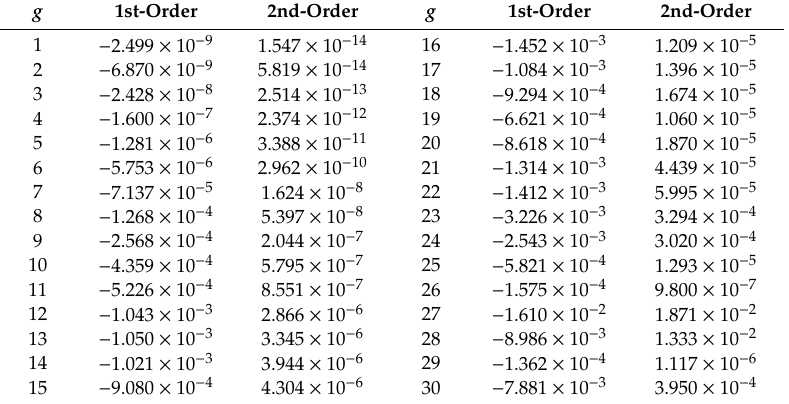
Table 20. Comparison of 1st-order relative sensitivities 2nd-order relative sensitivities sections for isotope 2 ( 240 Pu).